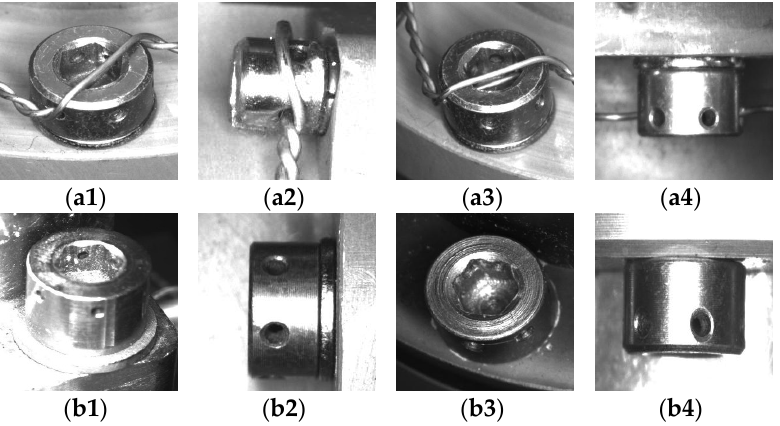
Figure 1. Assembly sample images: ( a1 – a4 ) Qualified assemblies; ( b1 , b2 ) Samples without lead sealing; ( b3 , b4 ) Samples without lead sealing and gasket.